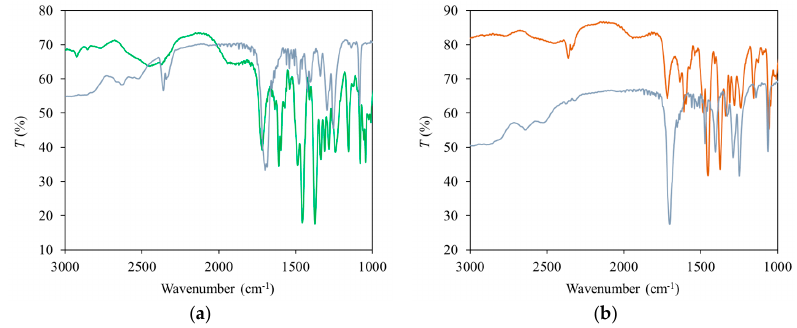
Figure 3. ( a ) IR spectra for 1-Cl (green line) and H 2 Cl 2 TPA (gray line); ( b ) IR spectra for 1-Br (brown line) and H 2 Br 2 TPA (gray line).